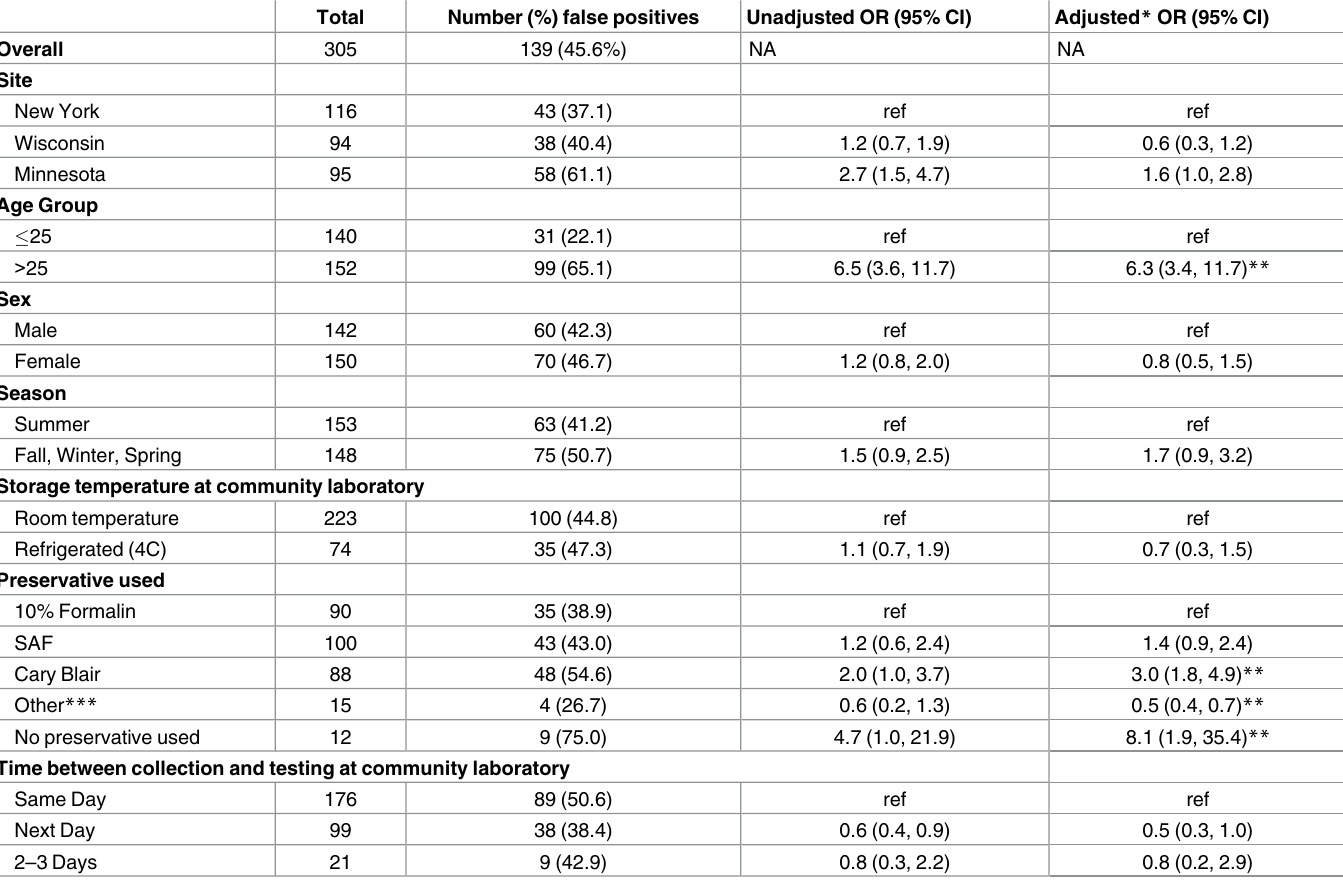
Table 3. Predictors of false positive results (using direct fluorescent antibody testing (DFA) as the gold standard) for stool specimens that tested positive for Cryptosporidium infection by Meridian Immunocard Stat! rapid cartridge assay at community laboratories (n =